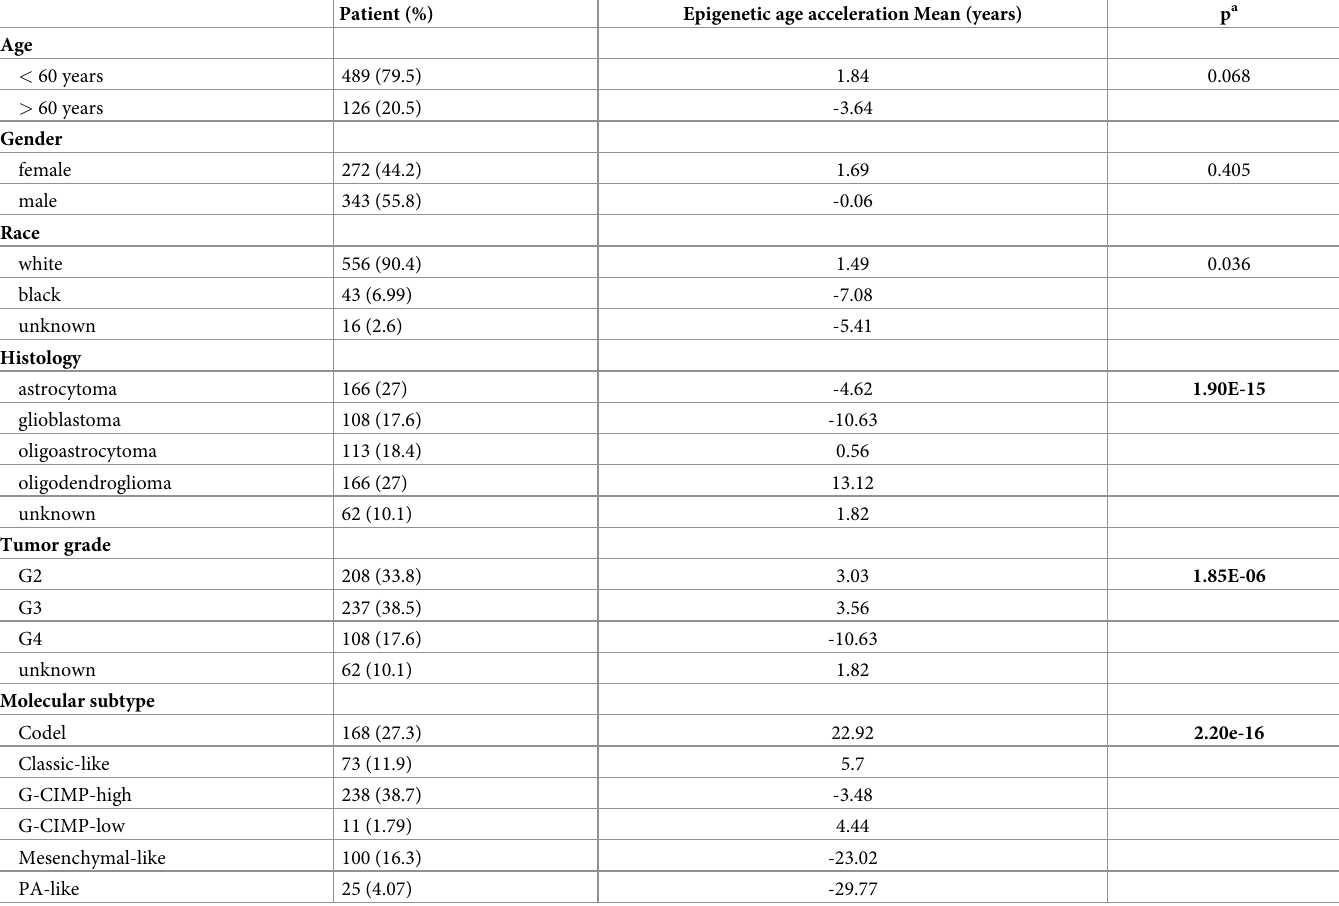
Table 1. Patient characteristics and the associations of epigenetic age acceleration with clinical